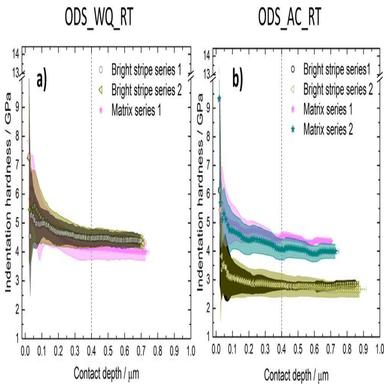
Plots indicating indentation hardness as a function of contact depth for a) ODS_WQ_RT and b) ODS_AC_RT (data obtained from \)